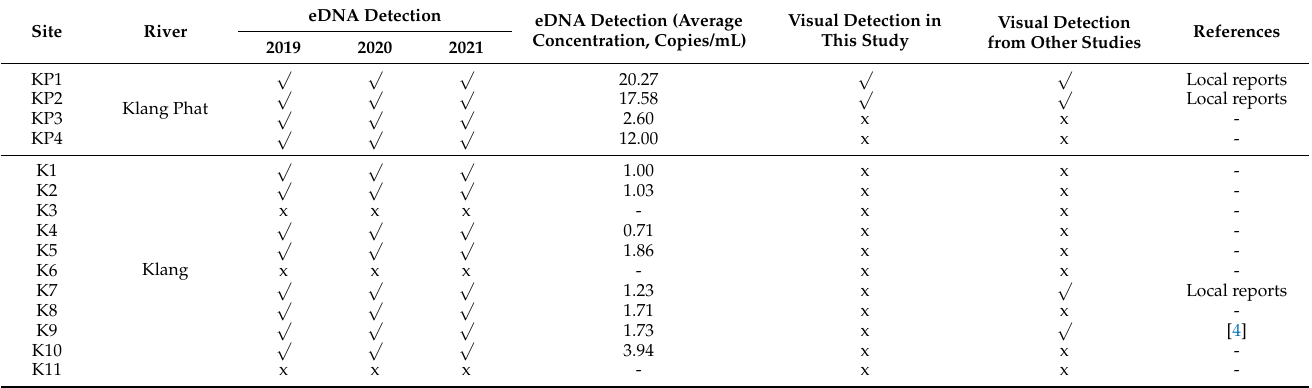
Table 3. eDNA detection (2019–2021), average O. siamensis eDNA concentration (copies/mL), and visual observation record at each sampling site. eDNA Detection eDNA Detection (Average Visual Detection in River Concentration, Copies/mL) This